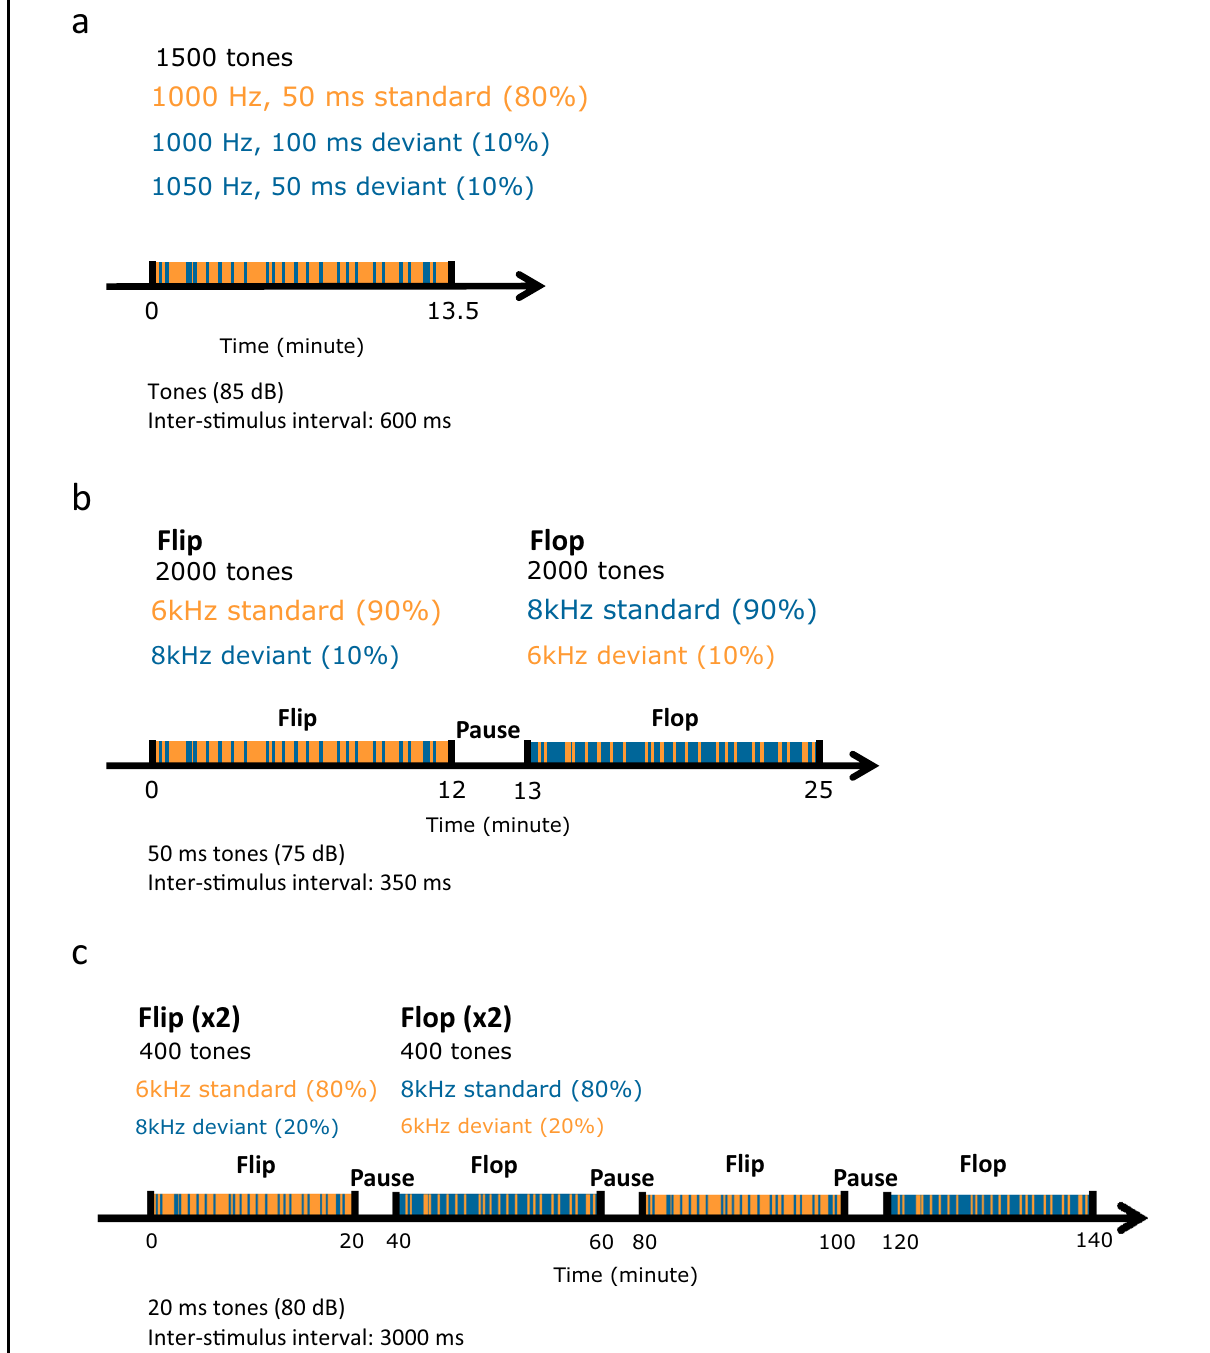
Fig. 1 Auditory MMN procedure across species. Schematic overview of the auditory stimulation protocols used to elicit MMN response in human subjects ( a ), rats ( b ), and mice ( c